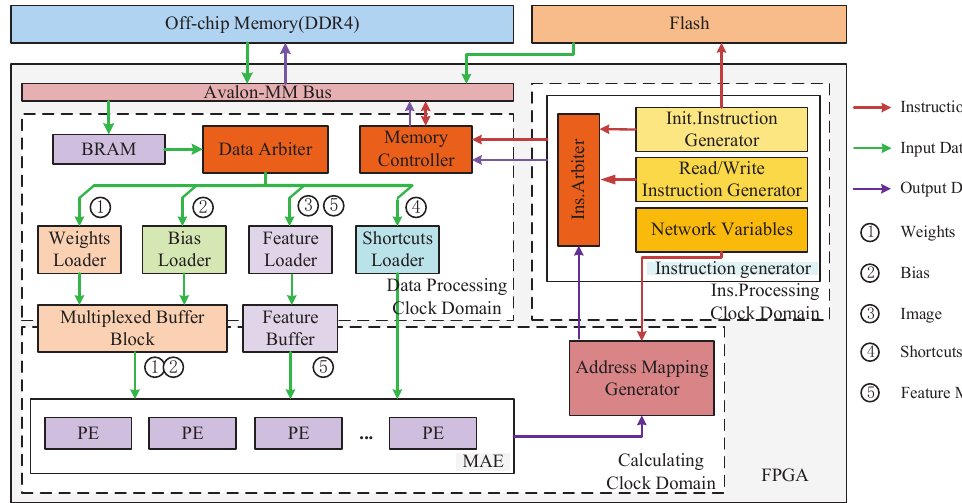
Figure 2. The overall architecture of the proposed